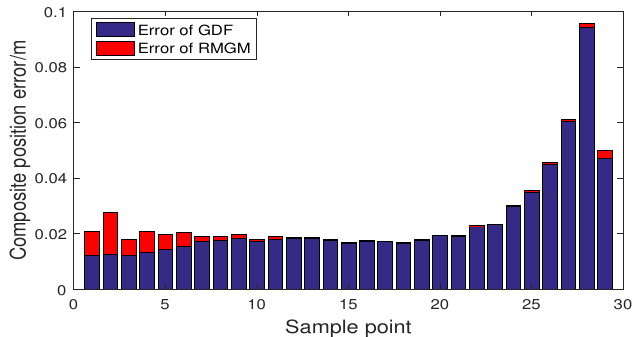
Figure 17. Combined position errors of GDF and